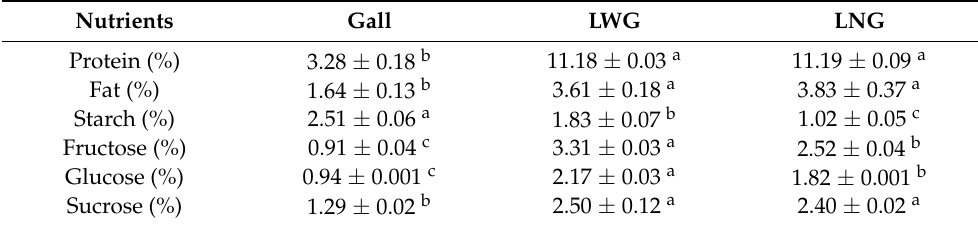
Table 2. The percentage of different types of nutrients in dried tissues.